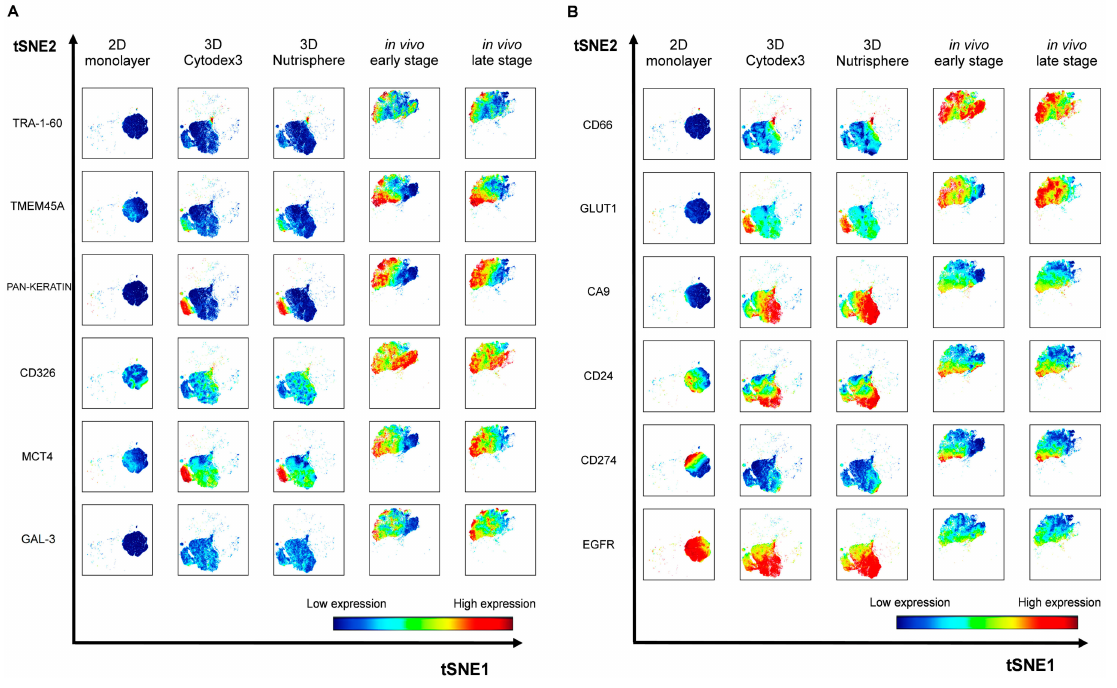
Figure 6. Representative multidimensional visualization of stochastic neighbor embedding (viSNE) analysis of 12 protein markers at single cell resolution in 2D, 3D (3D Cytodex3 or 3D Nutrisphere) cultures and in vivo (early or late stage) tumors. The analysis was performed within 4.5 × 10 4 HLA-A,B,C positive cells in case of all conditions in order to identify human A549 cells in the xenografts and exclude murine stromal cells. (iterations = 1000, perplexity = 30, theta = 0.5). Single cells are mapped based on the expression of all 12 markers within each